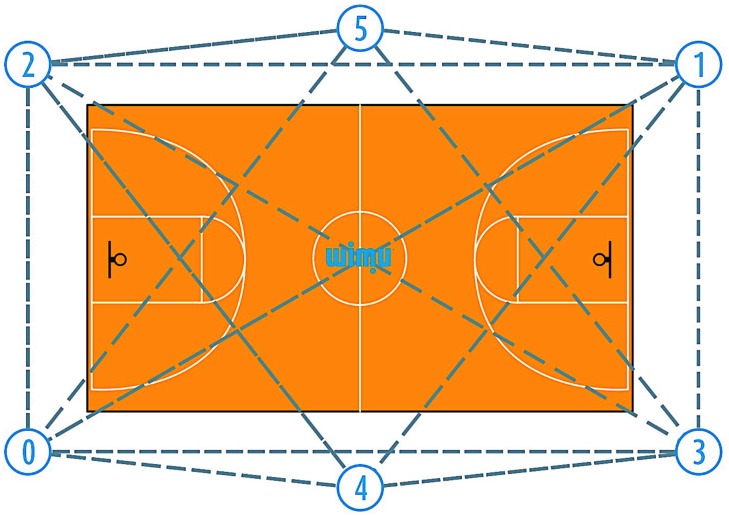
Ultra-Wide Band Antennae court setting/positions.